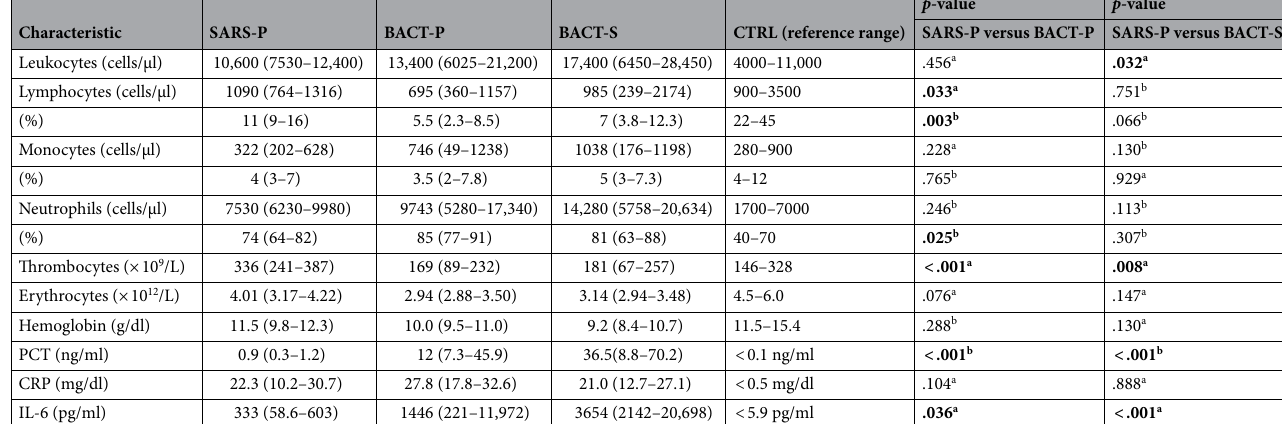
Table 2. Blood cell count and proinflammatory markers of patients with SARS-CoV-2 pneumonia (SARS-P, n = 12), bacterial pneumonia (BACT-P, n = 16), bacterial sepsis with origin other than pneumonia (BACT-S, n = 15) and of healthy control subjects (CTRL, n = 11). Significant values are in [bold]. Values are median (IQR). a two-tailed unpaired Student’s t -test, b Mann–Whitney- U